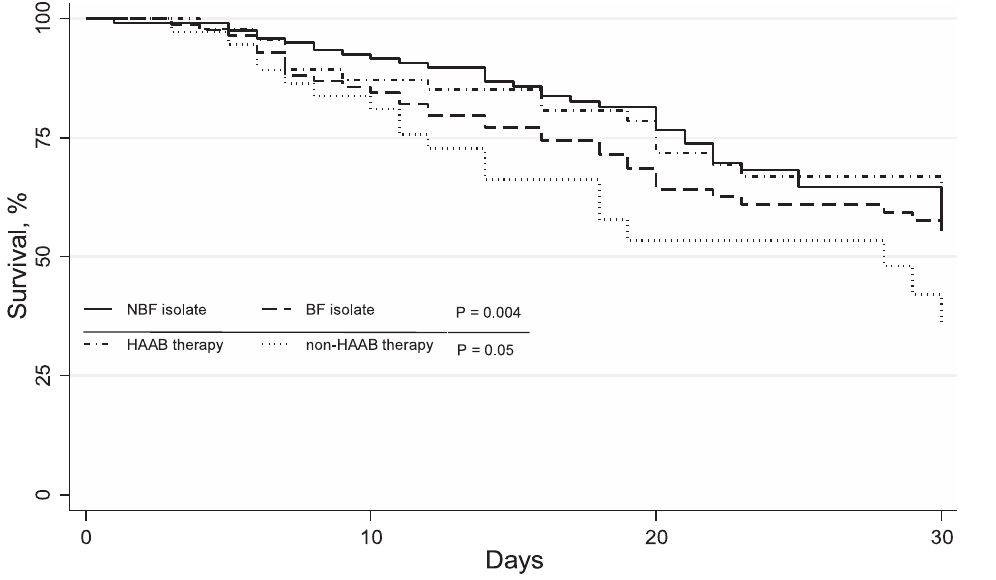
Figure 1. Survival among patients with Candida bloodstream infection (CBSI) at 30 days. Patients were grouped according to the biofilm- forming (BF) or non-biofilm-forming (NBF) Candida isolate (for all CBSIs), and according to receiving of highly active anti-biofilm (HAAB) or non-HAAB antifungal therapy (for BF CBSIs only). P-values for statistically significant differences between the groups are shown.